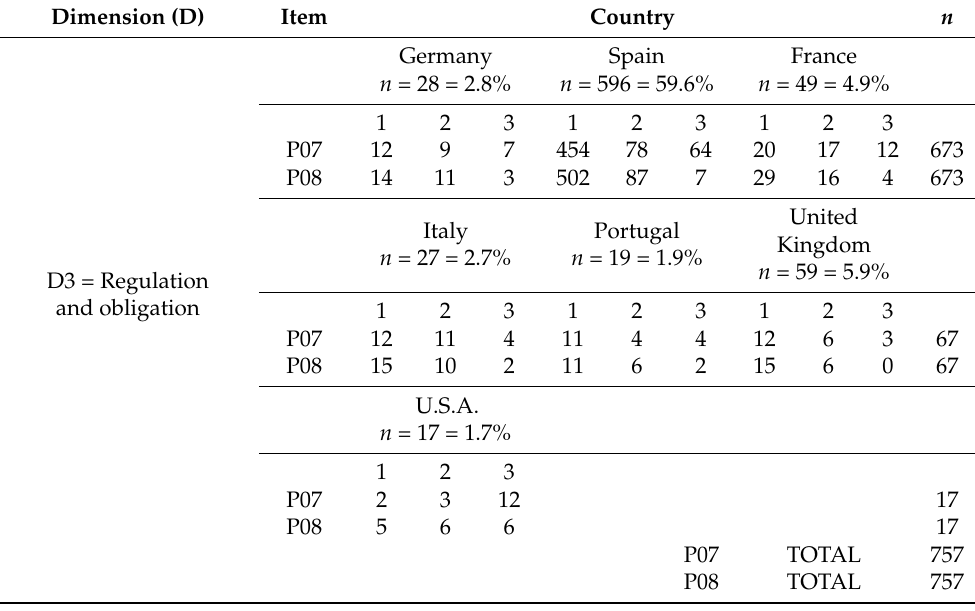
Table 14. Country count of the participating sample for dimension D3.